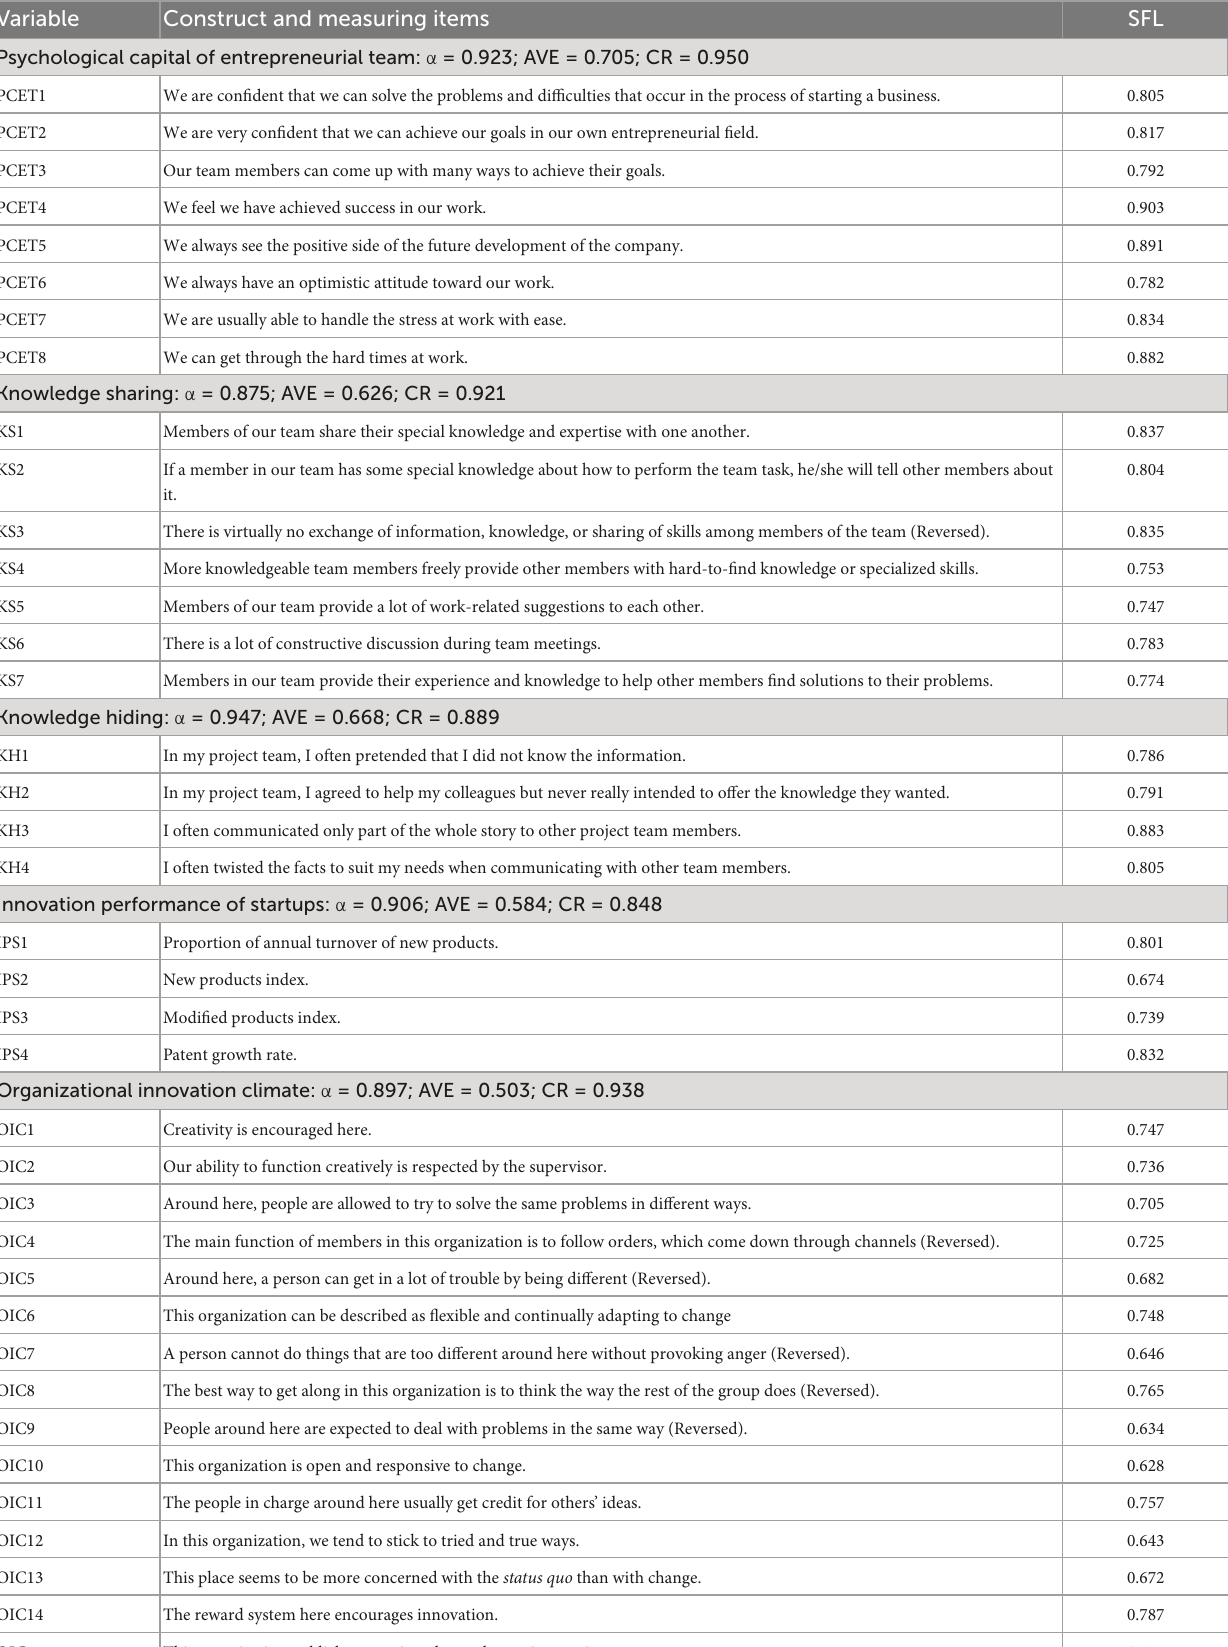
TABLE 2 Sample validity and reliability assessment of the measures. Variable Construct and measuring items SFL Psychological capital of entrepreneurial team: α = 0.923; AVE = 0.705; CR = 0.950